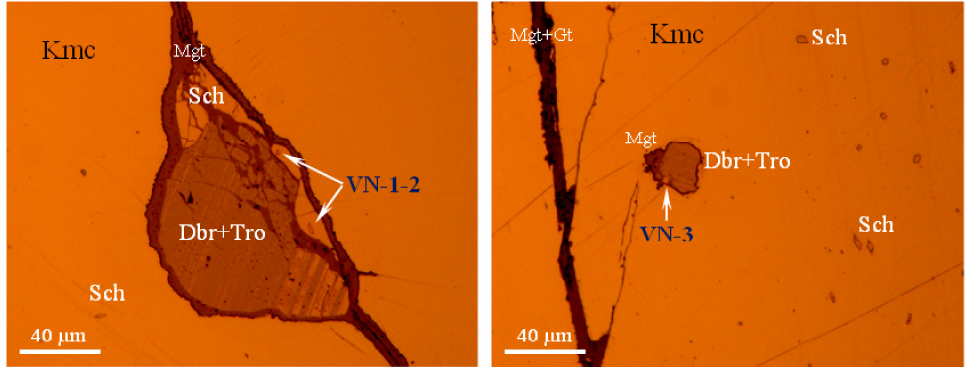
Figure 4. Uakitite in troilite + daubr é elite ± schreibersite globules in Fe-Ni-metal (kamacite), Uakit meteorite (IIAB), images in reflected light. Symbols: VN-1–VN-3—uakitite; Dbr—daubr é elite; Tro—troilite; Sch—schreibersite; Mgt—magnetite; Gt—goethite;